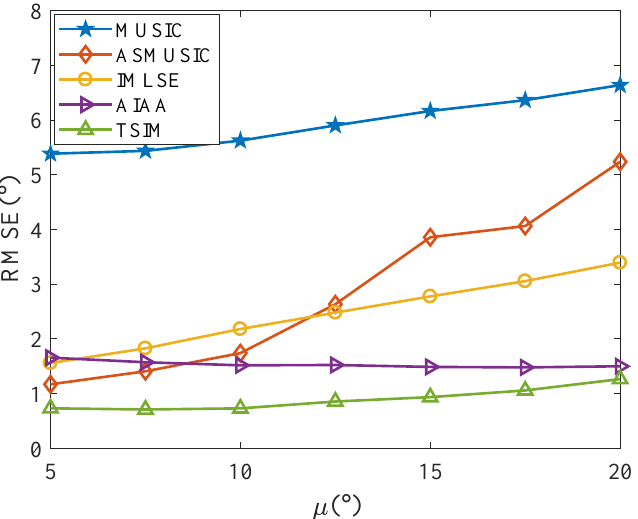
Figure 4. RMSE versus µ with SNR = 5 dB, L = 300, and σ = 4 under non-uniform